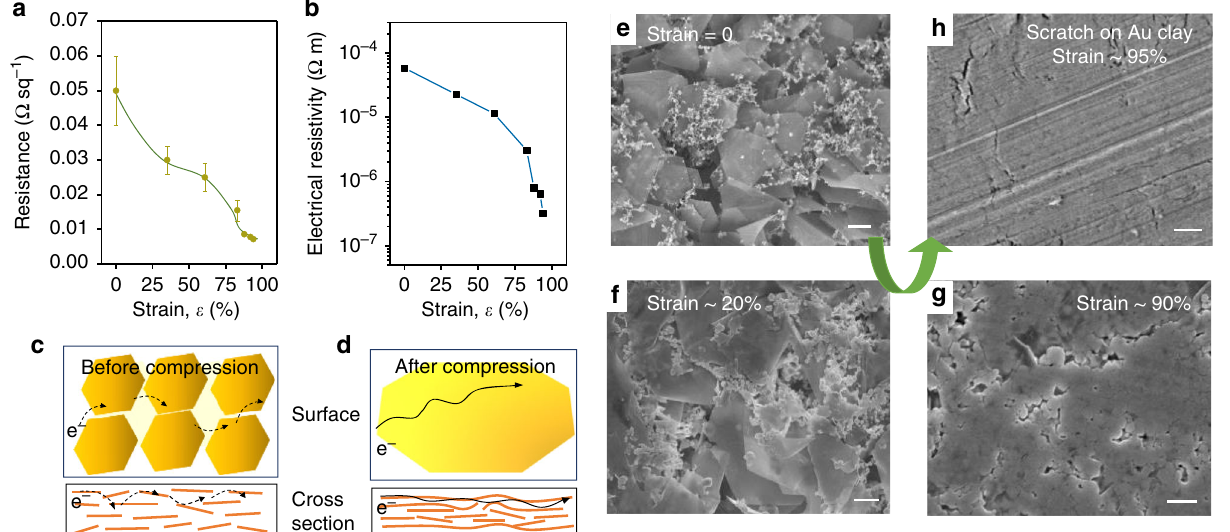
Fig. 6 Stress/strain-dependent conductivity and morphology change during compression. a , b Stress/strain-dependent electrical conductivity of the gold nanosheet aggregates. Note that no thermal annealing was applied during measurements. Error bars are de fi ned as s.d. c , d Schematic illustrations of the surface and cross-sectional changes of the gold nanosheet aggregates before and after mechanical compression. e – h Scanning electron microscopy images of surface morphologies with increasing stress/strain at room temperature. Scale bars: 1.0 μ